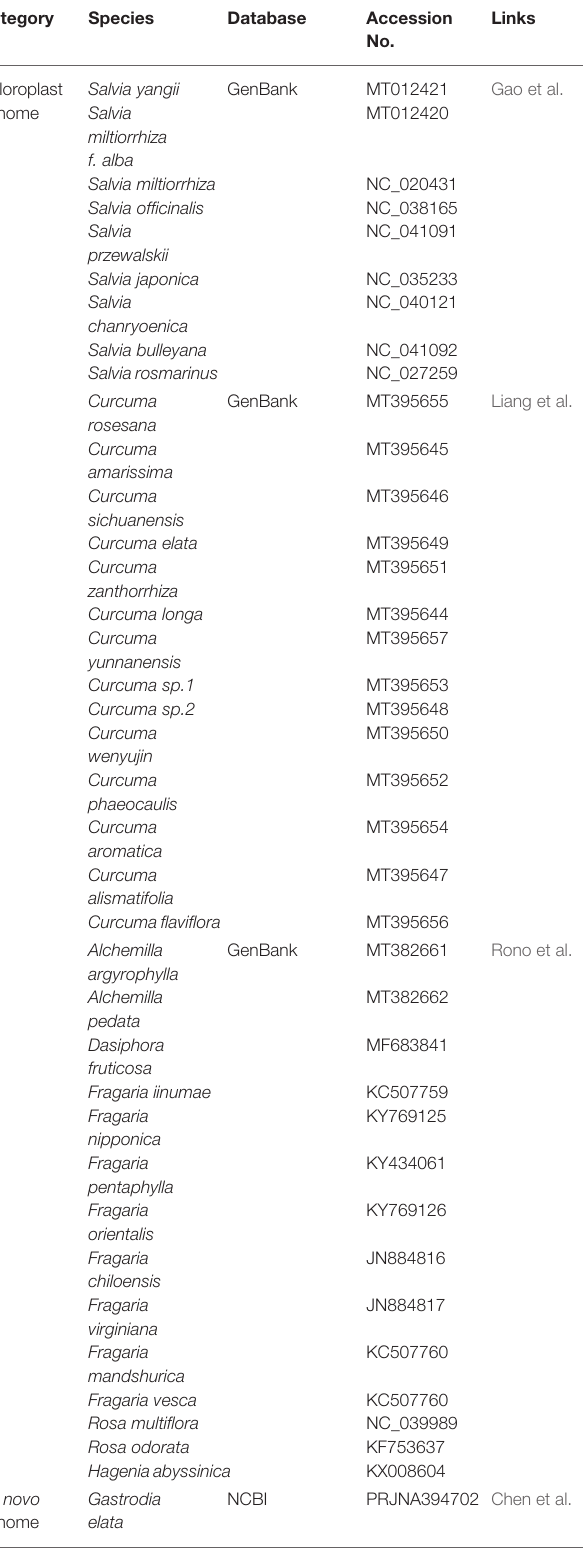
TABLE 1 | The list of chloroplast genome and de novo genome studies in this Research Topic.